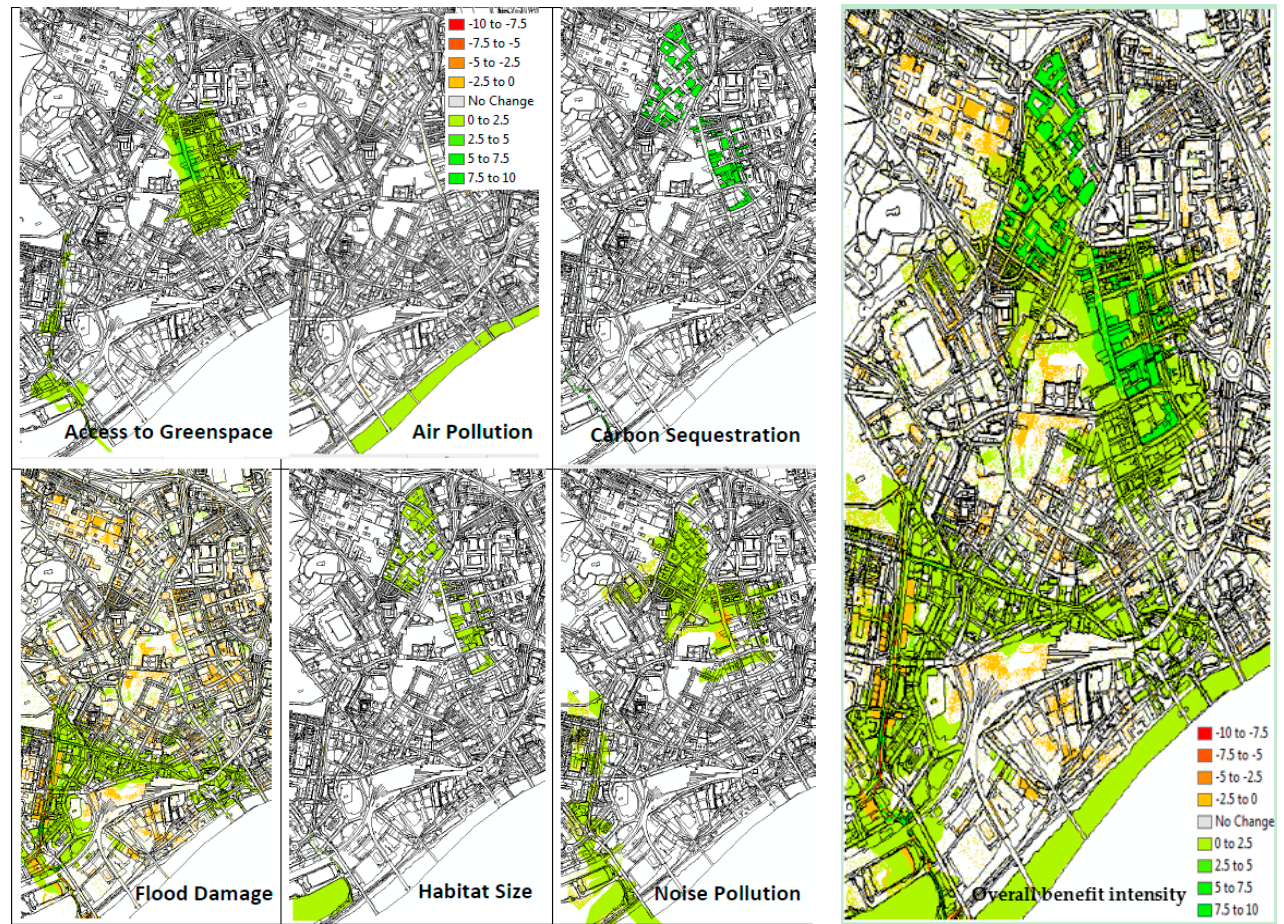
Figure 3. Spatial distribution of individual benefits and accumulation into an overall benefit intensity of SuDS interventions in Newcastle urban core.